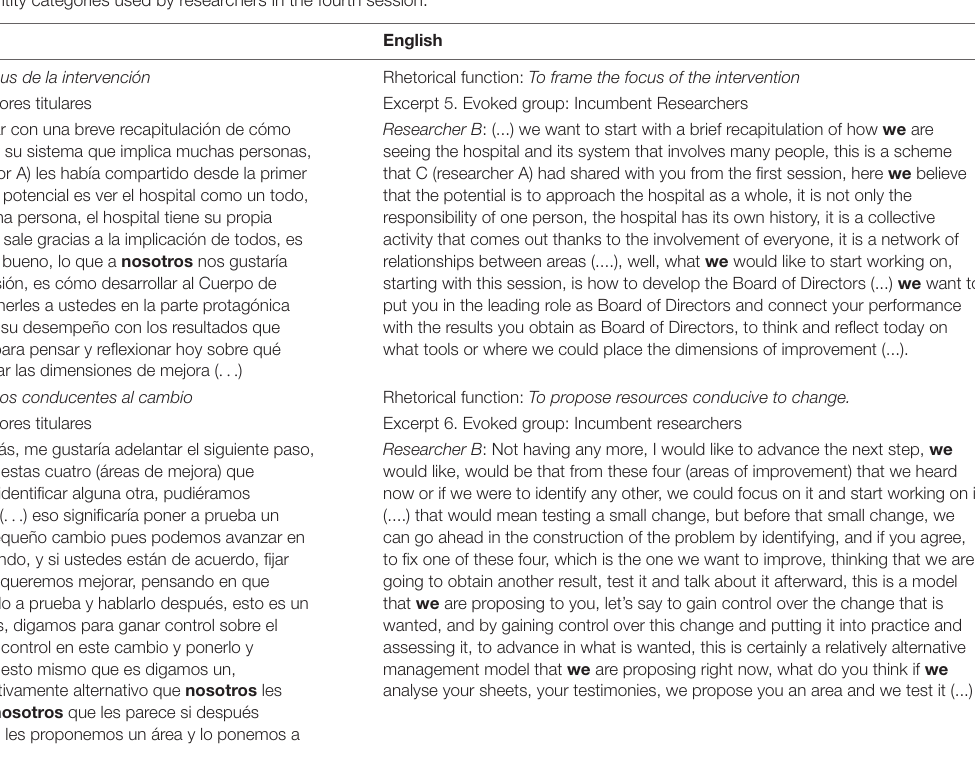
TABLE 3 | Exemplary excerpts of identity categories used by researchers in the fourth